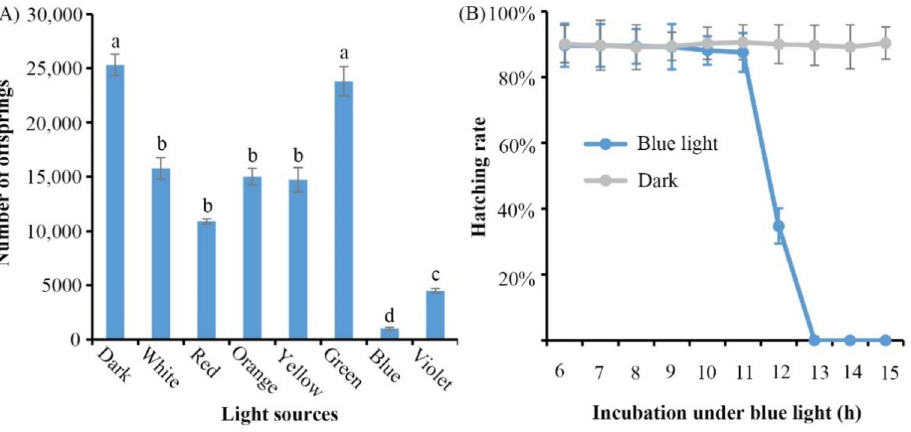
Figure 1. Effects of lights on the development of B. xylophilus . ( A ) Ten pairs (10 ♀ + 10 ♂ ) of virgin adult males and females were inoculated onto the mycelia of Botrytis cinerea and cultured under different light-emitting diode (1000 lx) at 25 °C for 7 days. The eggs incubated in dark conditions were used as a control. Different